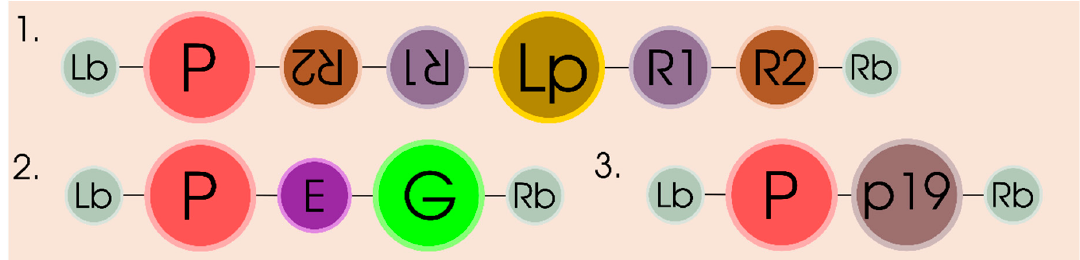
Figure 3. Scheme of T-DNA gene constructs for studying the physiological role of gene products in plants. 1 and 2—constructs for studying the physiological role of gene products in plants due to silencing (1) or overexpression (2) of the target gene, respectively; 3—construct for PTGS suppression, where R1, R2—repeats sequences of target gene forming stem structure; Lp—loop sequence; E—translation enhancer; P—a strong constitutive promoter; G—target gene; p19—gene for PTGS suppression; Lb, Rb—T-DNA left and right borders. Note, construct 3 may represent delivery as co-transformation with two vectors, one of which carries a silencing suppressor expression cassette and the other, a target gene expression cassette [50] or (ii) expression of the silencing suppressor and target sequence in the same expression cassette [24].